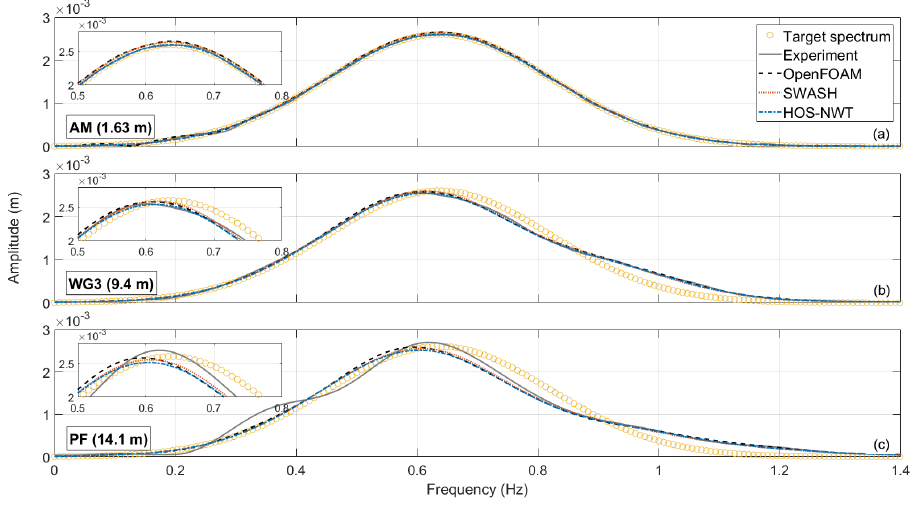
Figure 6. Amplitude dispersion from ( a ) AM, ( b ) WG3, ( c ) PF of the extracted linear